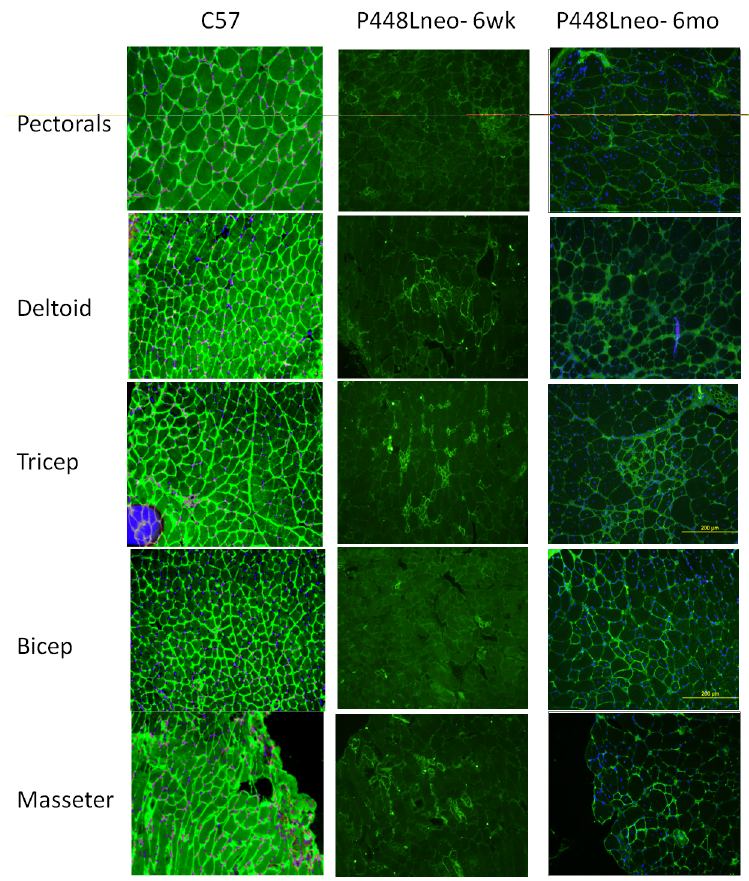
Fig 2. Presence of revertant fibers in forelimb, trunk, and head of P448Lneo- mutant mouse. Forelimb includes deltoid, triceps and bicep while trunk and head include pectorals and masseter respectively. IIH6 staining shown in all muscle of C57, but mostly absent in both 6 week and 6 month old P448Lneo-. Varying numbers of revertant fibers are seen at the different ages of P448Lneo- . Images displayed at 20X magnification. Yellow bar (shown in 6 month triceps) represents 200